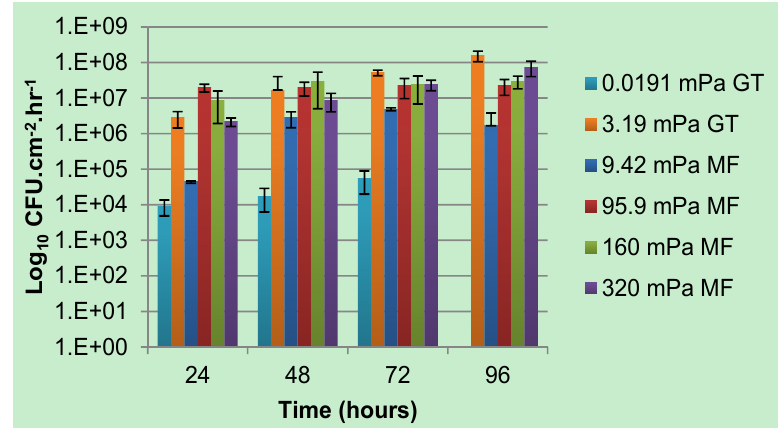
Figure 4. A comparison of biofilm-associated planktonic cell production rates from biofilms grown in microfluidic channels (MF, this study) and square glass tubes (GT, reference [18]) subjected to a wide range of average shear rates by varying the bulk-liquid flow rates. The inner dimensions of the square glass tubes were 2 mm × 2 mm × 152.4 mm (Friedrich & Dimmock, Inc., Millville, NJ,